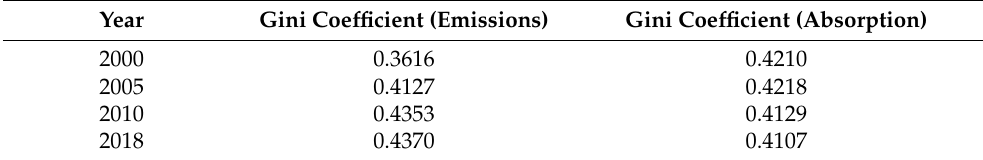
Table 2. The variation in the Gini coefficients.